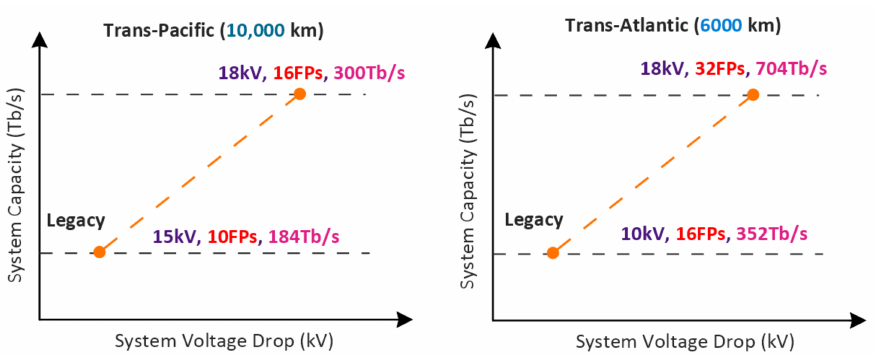
Figure 32. Comparison of two cable systems for different power (from legacy to the latest generation) and capacity values